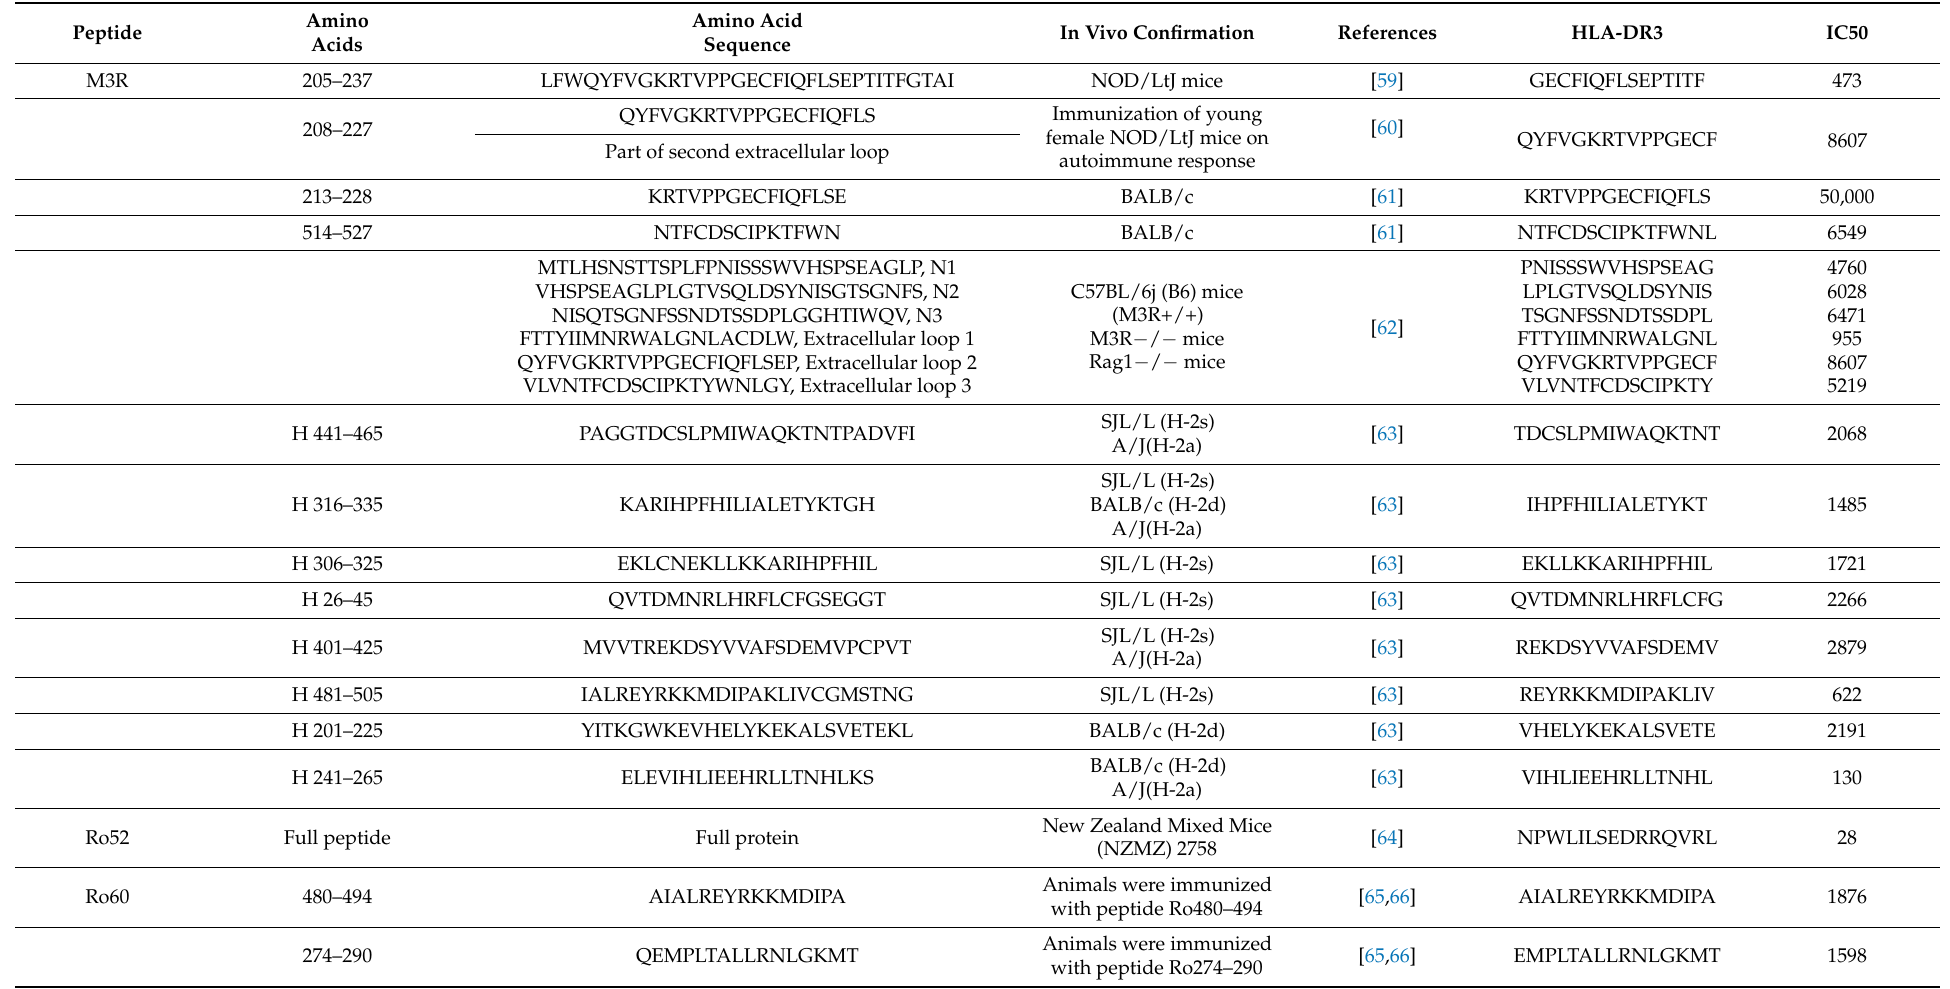
Table 3. Peptides for SjS that have been tested in